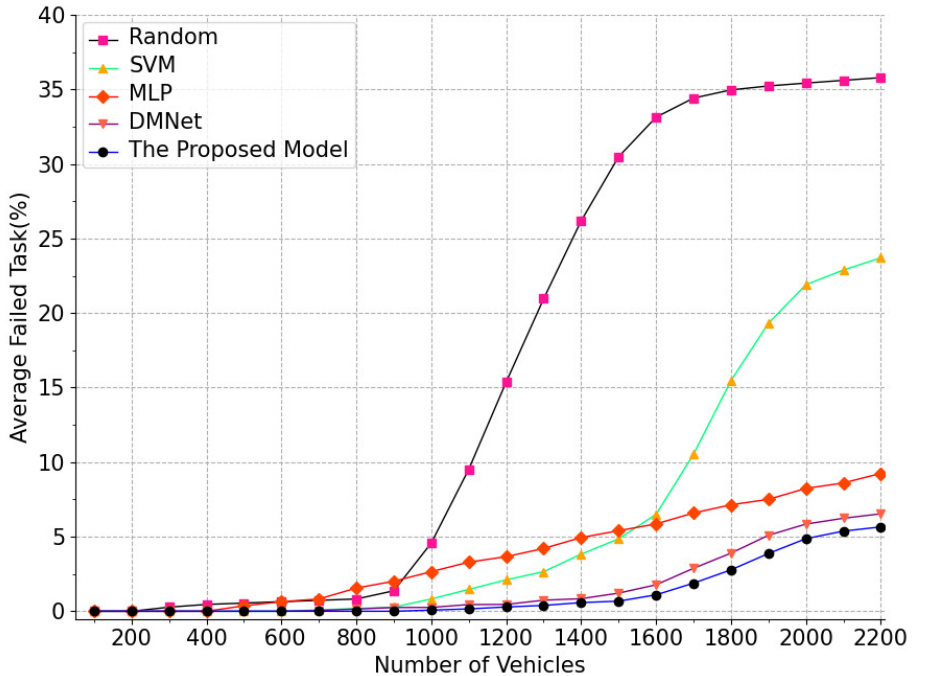
Figure 11. The performance comparison of different